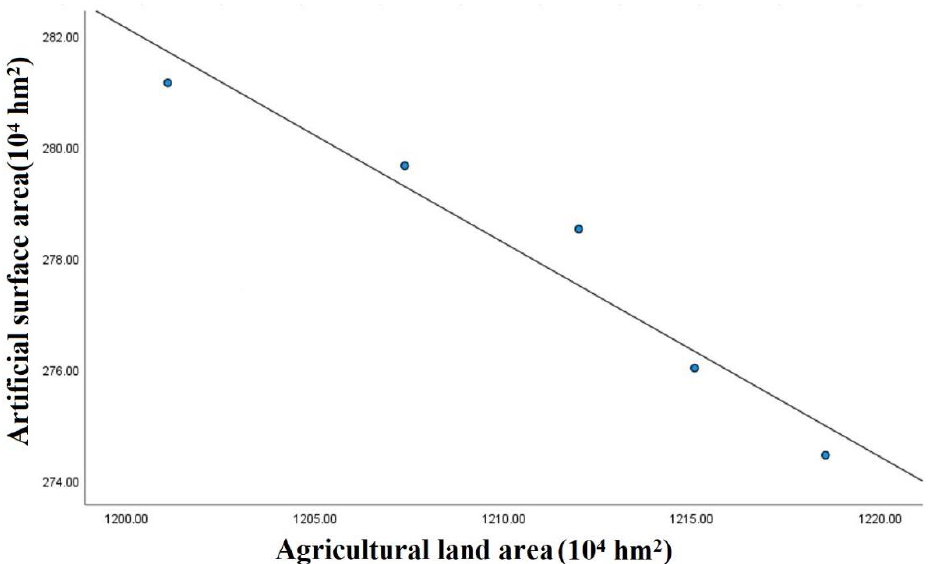
Figure 12. Correlation analysis of agricultural land area and artificial land surface area.